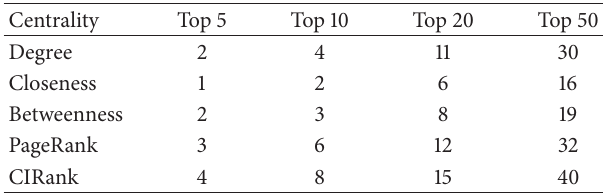
Table 4: Centrality measures ranking